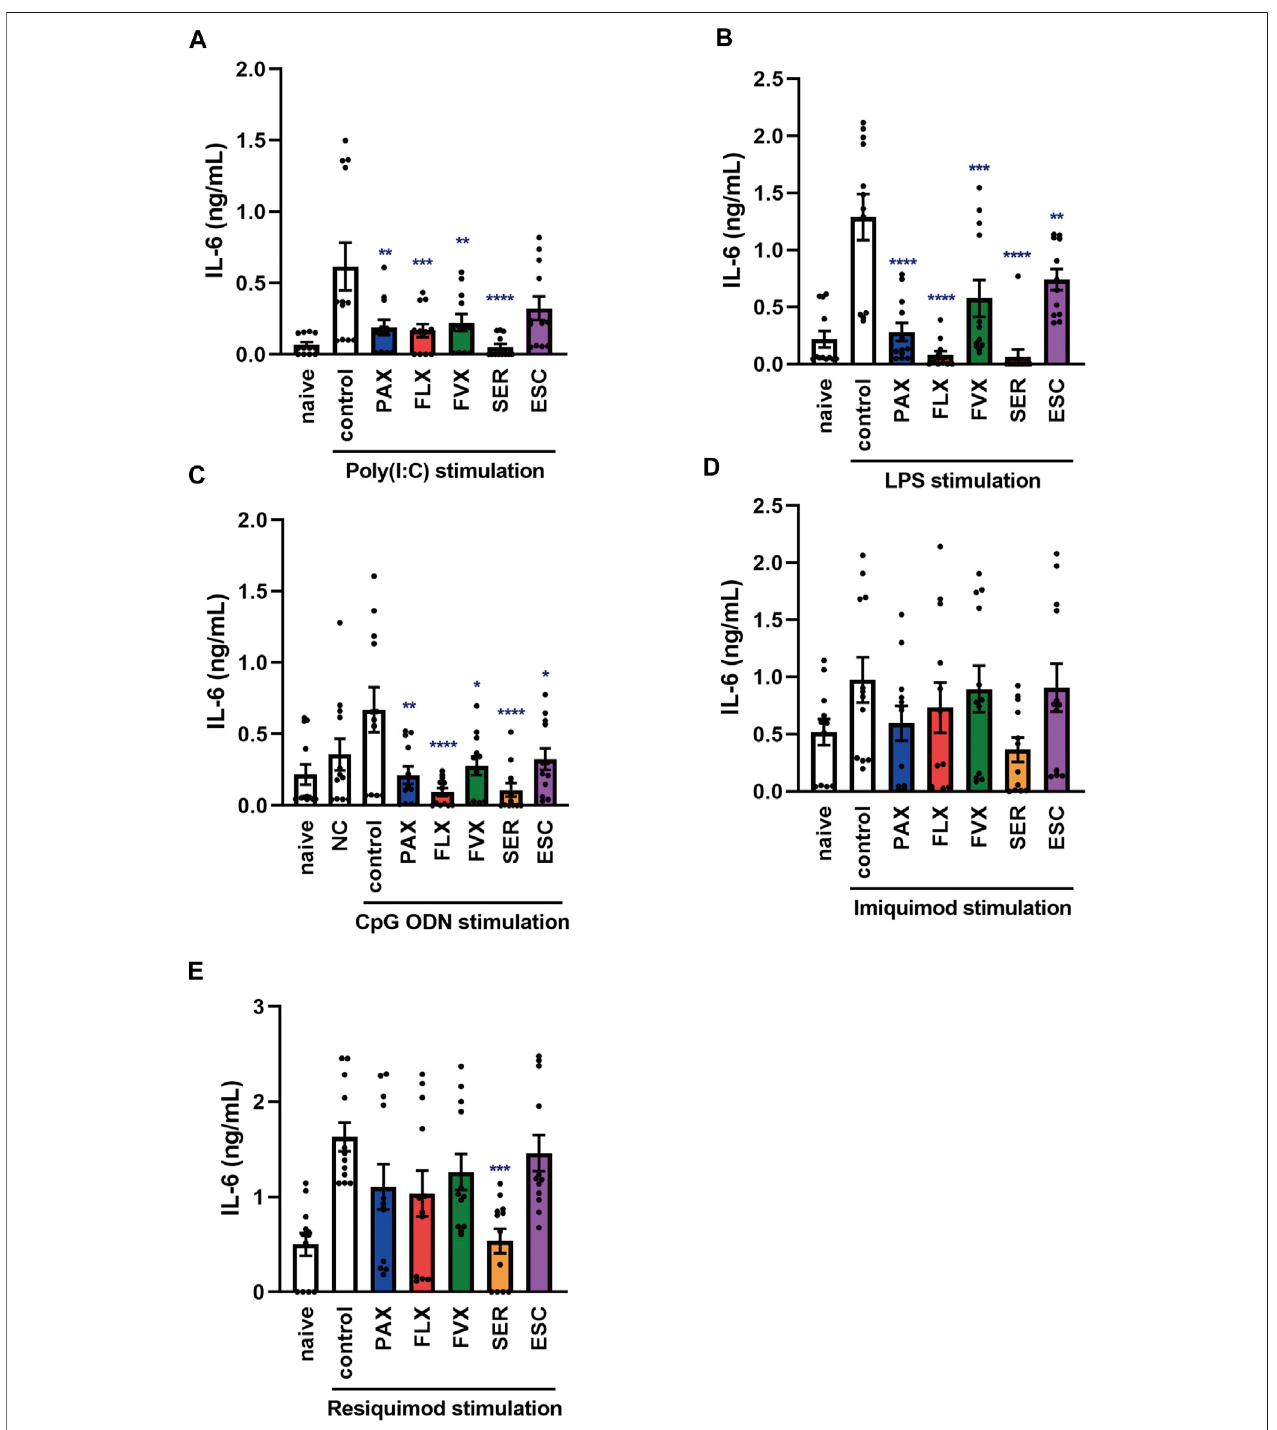
FIGURE6| EffectsofSSRIsonIL-6productioninducedbyTLRagonistsinmurineperitonealcells.PeritonealcellsisolatedfromC57BL/6micewerepre-incubated with each SSRI (1 – 10 µM) for 30 min and then incubated with poly(I:C) (5 μ g/ml) (A) , LPS (1 μ g/ml) (B) , CpG ODN or negative control ODN (200 ng/ml) (C) , imiquimod (1 μ g/ml) (D) or resiquimod (10 ng/ml) (E) for 24 h. IL-6 was measured by means of ELISA. Error bars indicate ±SE ( n = 12, three independent experiments). Statistical analysis was performed by one-way ANOVA followed by Dunnett ’ s test. Signi fi cant differences between control and test groups are indicated by * p < 0.05, ** p < 0.01, *** p < 0.001, **** p < 0.0001. NC, negative control ODN. PAX, paroxetine; FLX, fl uoxetine; FVX, fl uvoxamine; SER, sertraline; ESC, escitalopram.